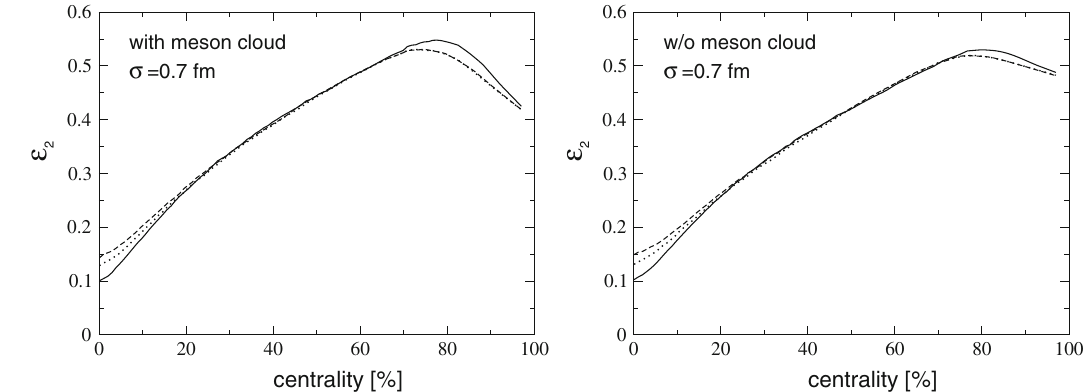
Fig. 3 Centralitydependenceoftherms ε 2 fortheGaussiansourcedis- (dashed) and symmetric Woods–Saxon distribution (dotted). Left: the √ s = 5 . 02 TeV tribution (8) for σ = 0 . 7 fm for Pb + Pb collisions at versionwithmesoncloudat α = 0 . 09.Right:theversionwithoutmeson √ s = 5 . 44 TeV for the θ -dependent (solid) and Xe + Xe collisions at cloud at α = 0 .